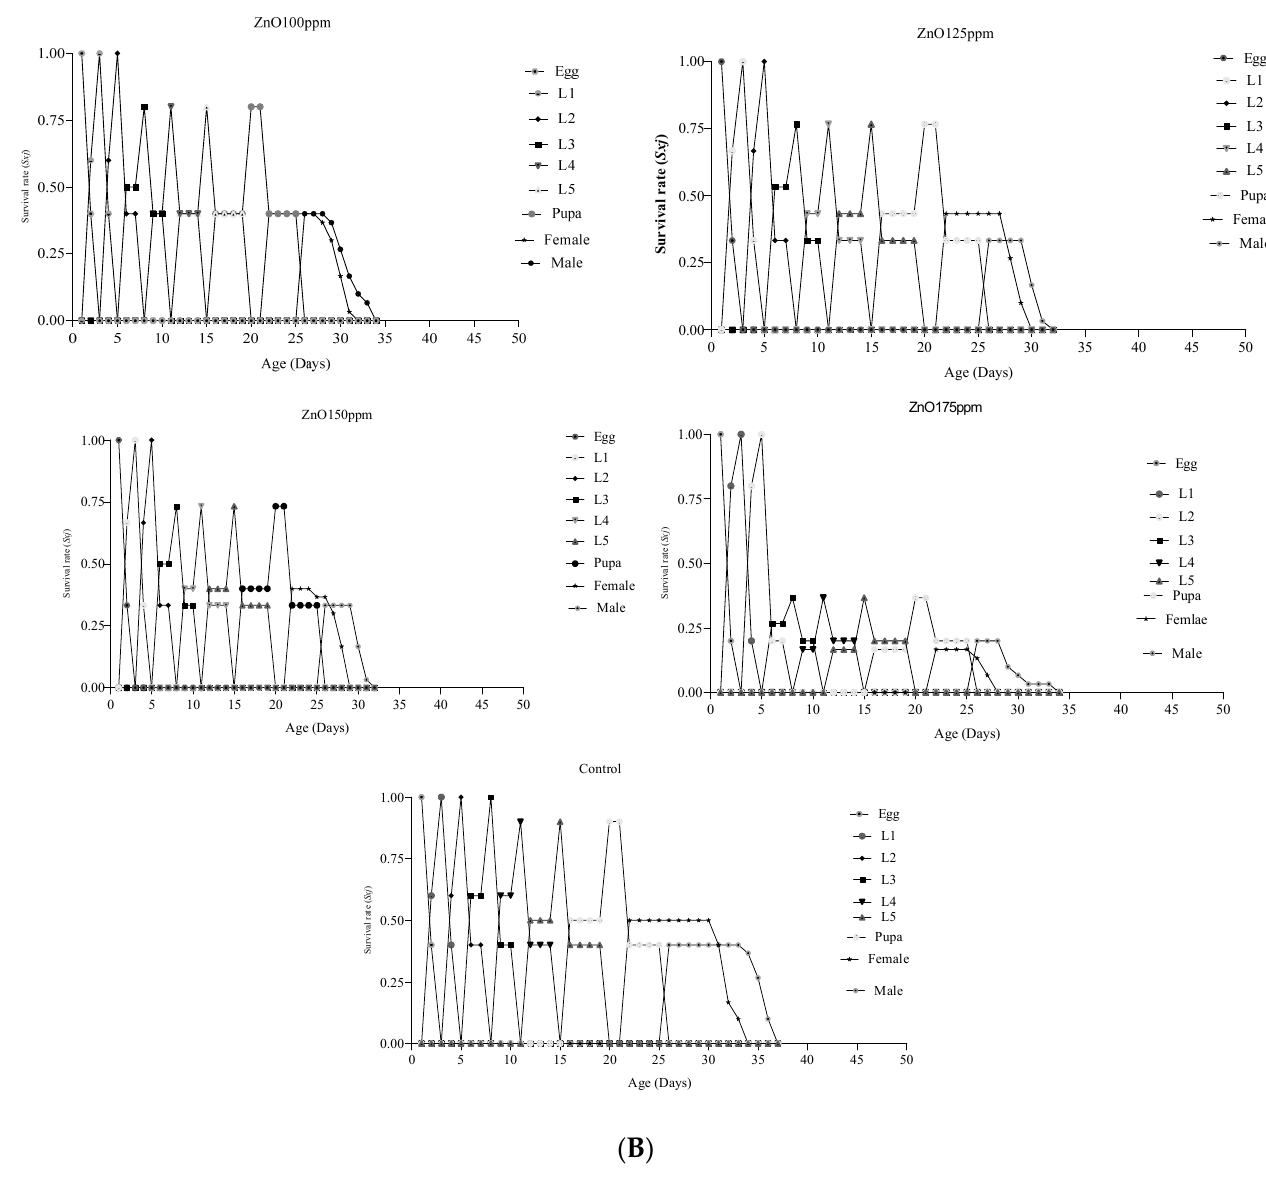
Figure 3. ( A ) Age-stage survival rate ( s xj ) of 100, 125, 150, 175 ppm and control of NPs treated H. armigera . ( B ) Age-stage survival rate ( s xj ) of 100, 125, 150, 175 ppm and control of NPs treated H. armigera .